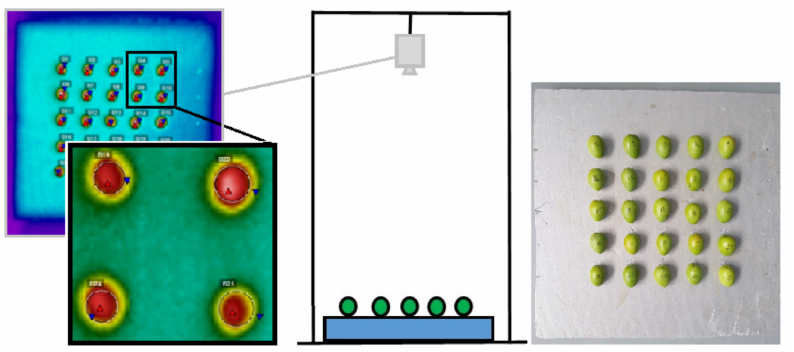
Figure 1. Thermographic camera located in the freezing chamber with a batch of 25 olives. Delin- eation of the olive measurement